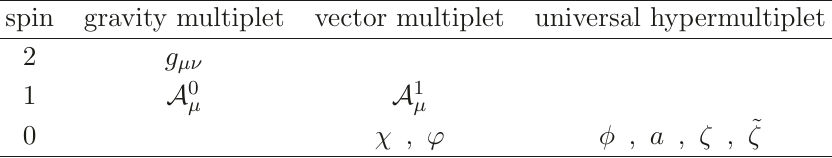
Table 1 . Bosonic fields in the multiplet in four